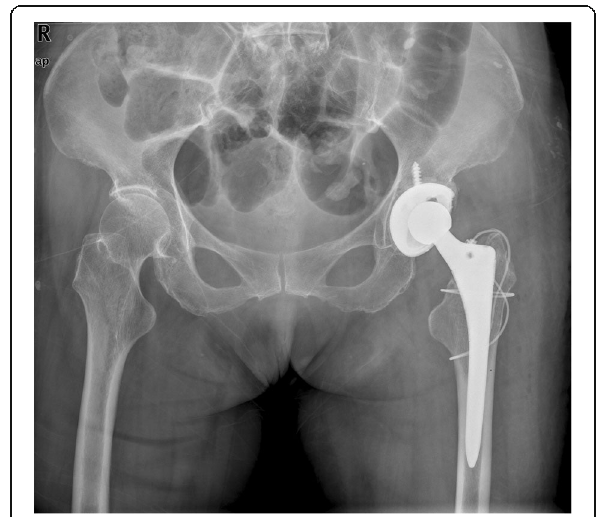
Fig. 5 Anteroposterior radiograph 2 years after ORIF showed reduction and fixation of the fracture, the fracture healed well, and the stem was